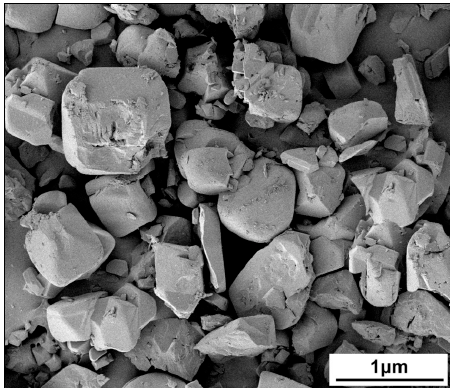
Figure 1. SEM image of fullerene powder with average particle size of 500 nm.